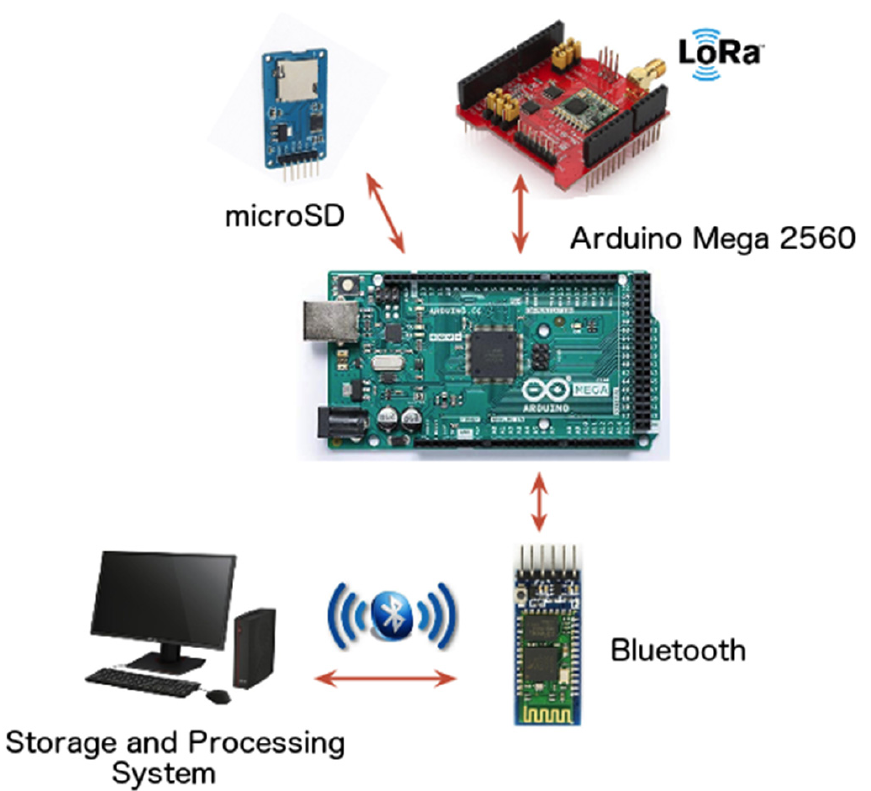
Figure 4. Structure of the communication system integrated in the UAV.